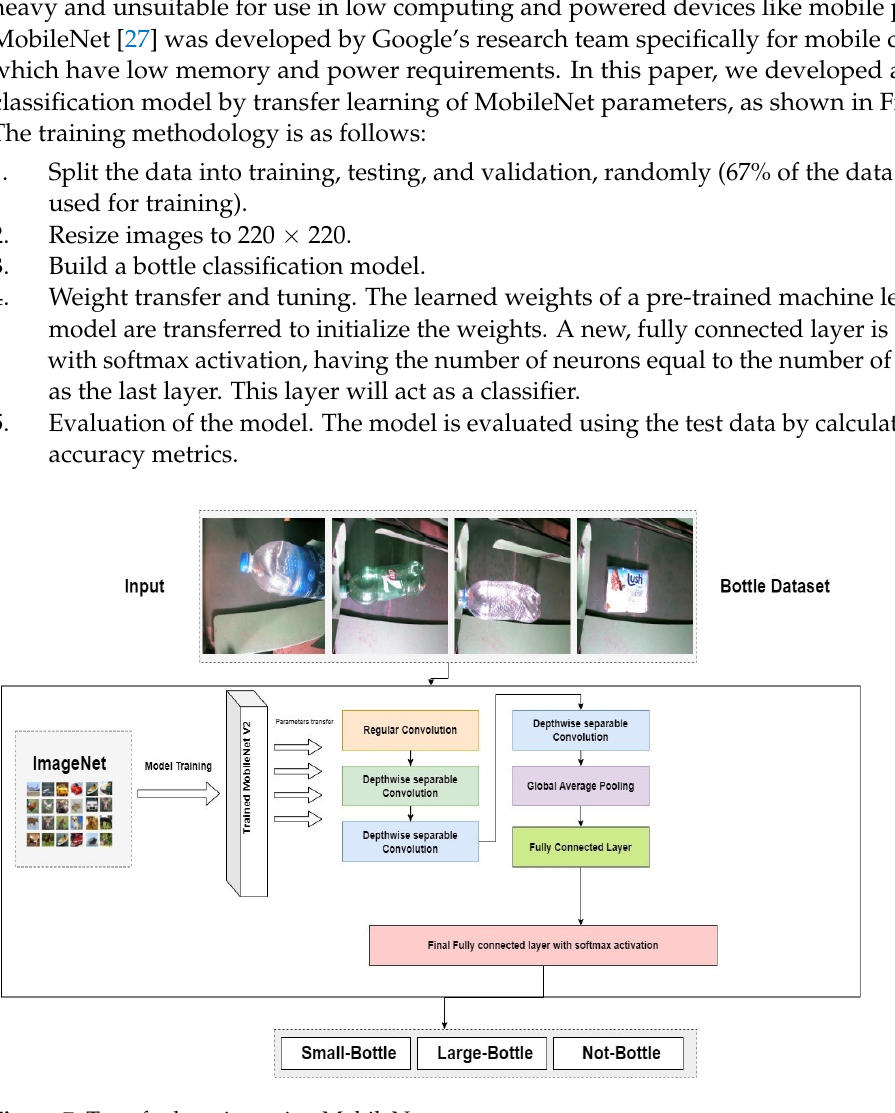
Figure 7. Transfer learning using MobileNet.